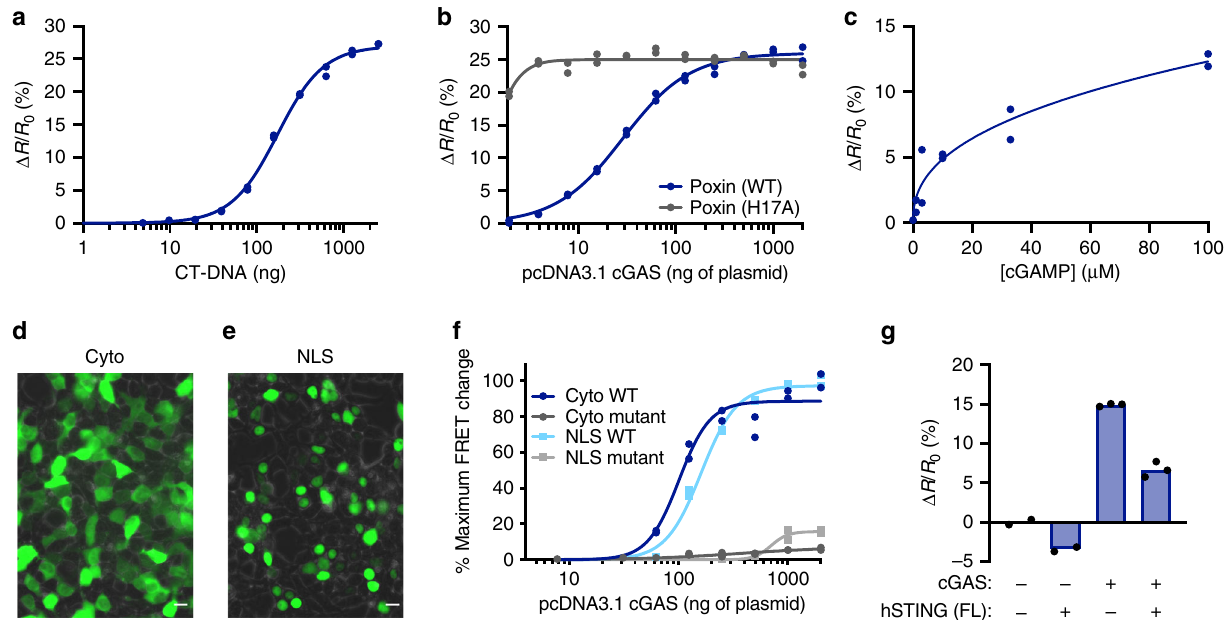
Fig. 5 BioSTING exhibits broad utility for monitoring diverse aspects of cGAMP signaling. a HEK293T cells stably expressing BioSTING were transfected with 10 ng of pCDNA3.1-cGAS for 16-20 h then transfected again with an increasing concentration of activating CT-DNA for 4 h and analyzed by fl ow cytometry. b HEK293T cells stably expressing BioSTING were transfected with 3 µ g of WT or H17A Poxin and increasing concentrations of pCDNA3.1- cGAS and analyzed for FRET response by fl ow cytometry. c Increasing concentrations of 2 ’ 3 ’ -cGAMP were added to the media of HEK293T cells stably expressing BioSTING for 6 h and analyzed for FRET response by fl ow cytometry. d – e BioSTING expression was induced in HEK293T cells transduced